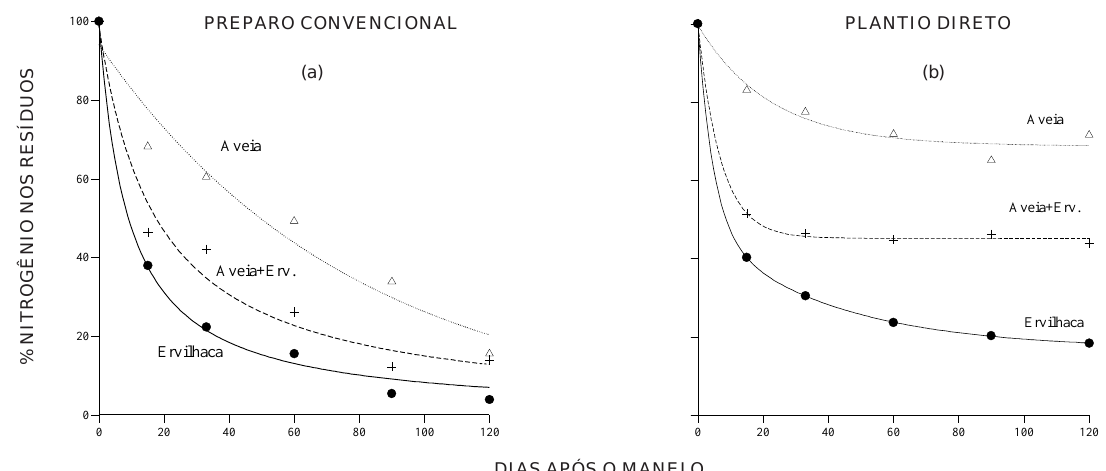
Figura 2. Velocidade de decomposição de resíduos culturais sob preparo convencional (a) e plantio direto (b) avaliada pela utilização de sacos de